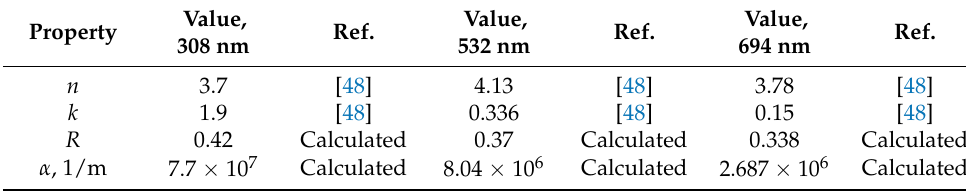
Table A10. c -GaAs—optical properties.